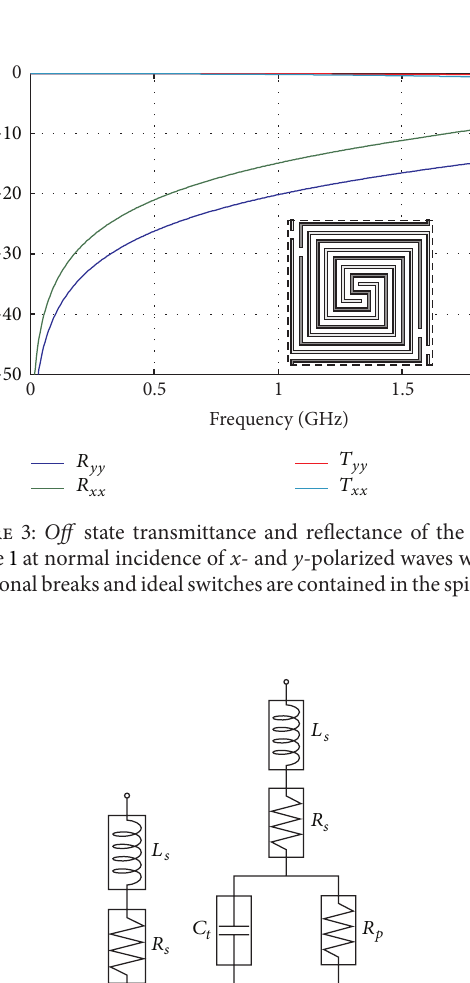
Figure 2: Transmittance and reflectance of the AFSS with the unit cell of Figure 1 at normal incidence of x - and y -polarized waves when ideal pin diode switches are in the (a) on and (b) off states.